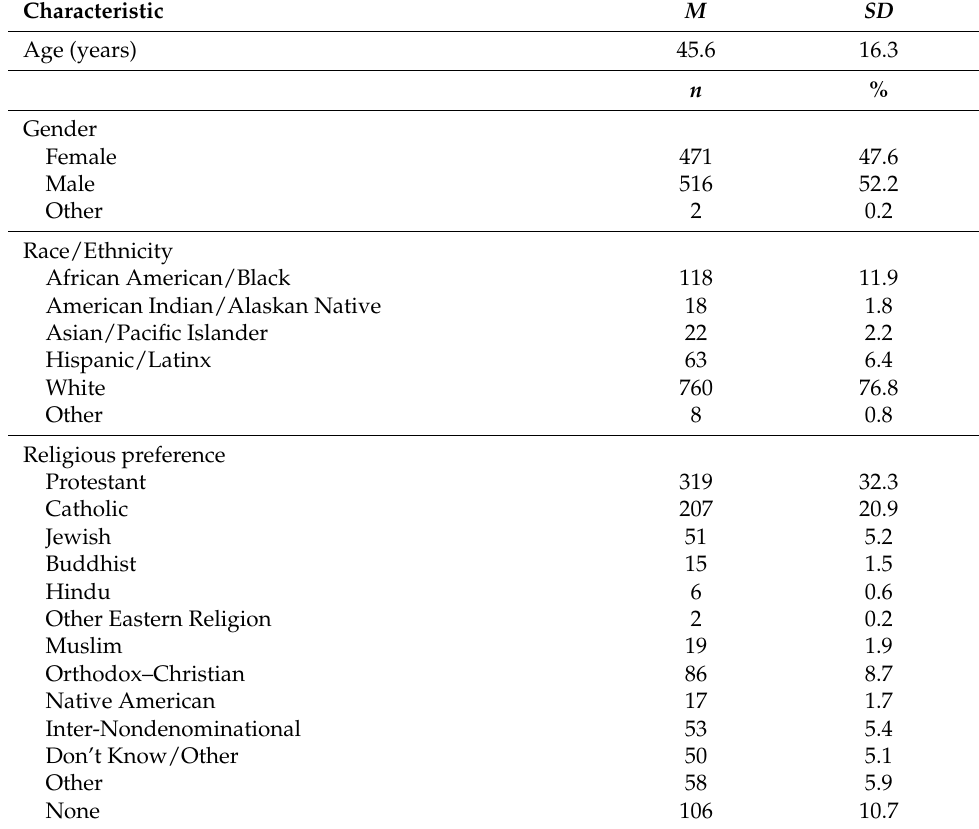
Table 1. Background Characteristics of Clients ( n =